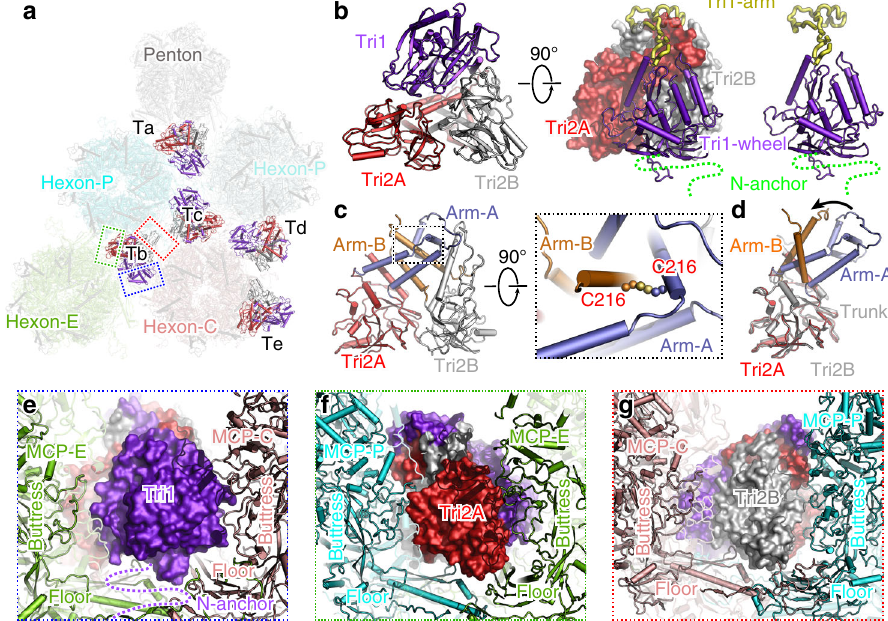
Fig. 5 Structure of the glue heterotriplex. a Overview of the heterotriplex distribution within an ASU in the capsid. The penton and hexon capsomers are set transparent to highlight the locations of the heterotriplex (colored by chains) at different sites. b Enlarged view of the Tri1 – Tri2 heterotriplex structure, colored by chains. The internal insertion arm of Tri1 is highlighted in yellow and the disordered N-terminal anchor is represented with dashed lines. c Interactions between the two Tri2 subunits within the heterotriplex. The interchain disul fi de bond between the embracing arms is shown as spheres in the enlarged box. d Comparison of the different conformations of the two Tri2 subunits in a heterotriplex. e – g Interactions between the heterotriplex (surface model) and capsomers (cartoon